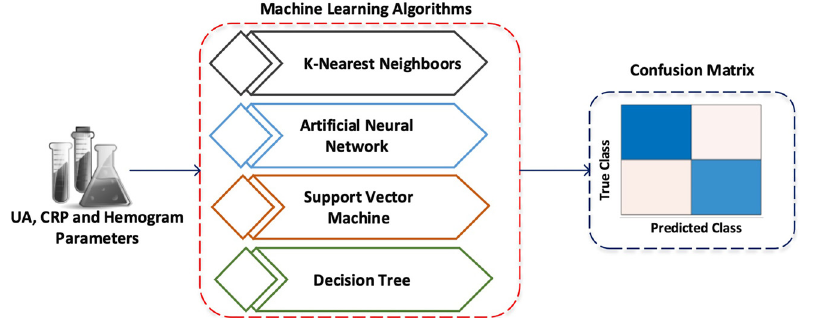
Figure 1: Illustration of the algorithm used in the